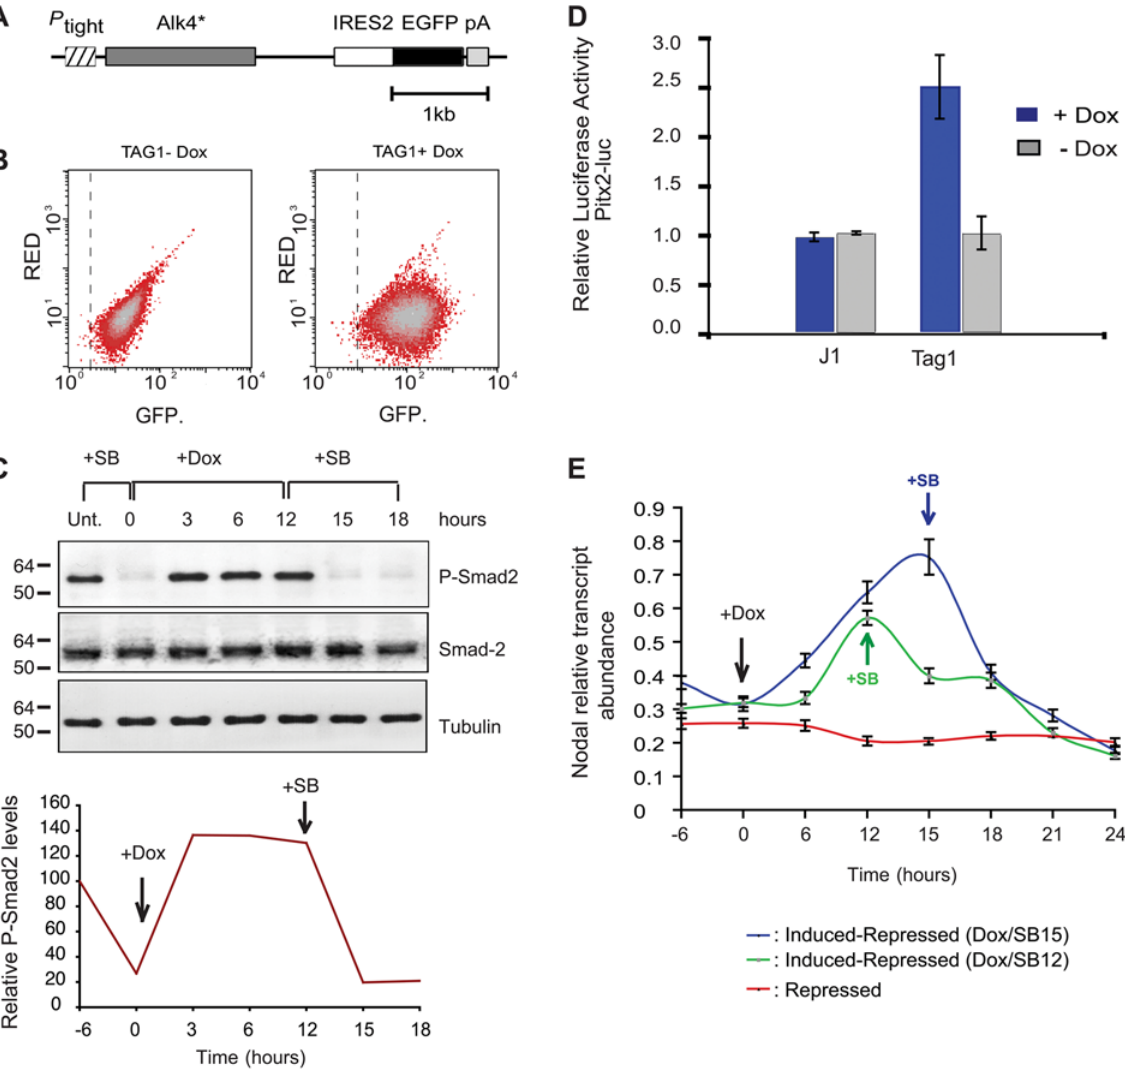
Figure 1. A tetracycline/Dox inducible Alk4*-receptor phosphorylates Smad2/3 and activates endogenous and exogenous targets in ES cells. (A) Schematic representation of the Alk4* inducible expression construct pSLTT-AIG . The tet-on inducible promoter ( P tight ) drives the transcription of a bicistronic message encoding the constitutive active Alk4* receptor (dark grey bar) followed by an internal ribosome entry site (IRES2, open bar), a GFP reporter (EGFP, black bar) and a polyadenylation signal (pA, light grey bar). The scale bar represents 1kb. (B) Two-colour FACS analysis of stable TAG1 ES cells cultured in the presence or absence of Dox for 18 hours. The y-axis represents red fluorescence while the x-axis represents GFP (green) fluorescence, both on a log 10 scale. Over 90% (broken line) of the Dox induced (TAG1 + Dox) ES cells display specific green fluorescence compared to the uninduced (TAG1-Dox) cells. (C) Western blot analysis of P-Smad2 levels during Alk4* induction and subsequent SB inhibition in TAG1 ES cells. Cell extracts of each time point were analysed with P-Smad2, Smad2 and Tubulin (loading control) antibodies. The curve derives from the densitometry analysis of the P-Smad2 bands on the western blot normalised against the Tubulin bands. All values are expressed relative to the untreated control (Unt.) represented as 100%. (D) Luciferase assays of the parental J1 cell line (cells that do not contain pSLTT-AIG construct) and TAG1 ES transfected with the Pitx2 luciferase reporter construct. Bars represent the relative increase of luciferase activity in the induced cells (blue) compared to uninduced cells (grey), for both J1 and TAG1 ES cells. Error bars represent the standard deviation in biological triplicates (n=3). (E) Quantitative real-time PCR of Nodal transcript in TAG1 ES cells treated sequentially with Dox inducer and SB inhibitor (at 15 hours in blue or 12 hours in green). A control set of cells was kept for the duration of the experiment in SB (red line). Relative Nodal transcript abundance is expressed as the average of 4 PCR reactions (n=4) normalised to the average of the housekeeping control genes Gapdh , Ube , Ywhaz and B2m with standard error of the mean of PCR reactions. Cells were pre-treated with SB for 6 hours to reduce autocrine-signalling and target gene expression (time point 0) in (C) and (E) .